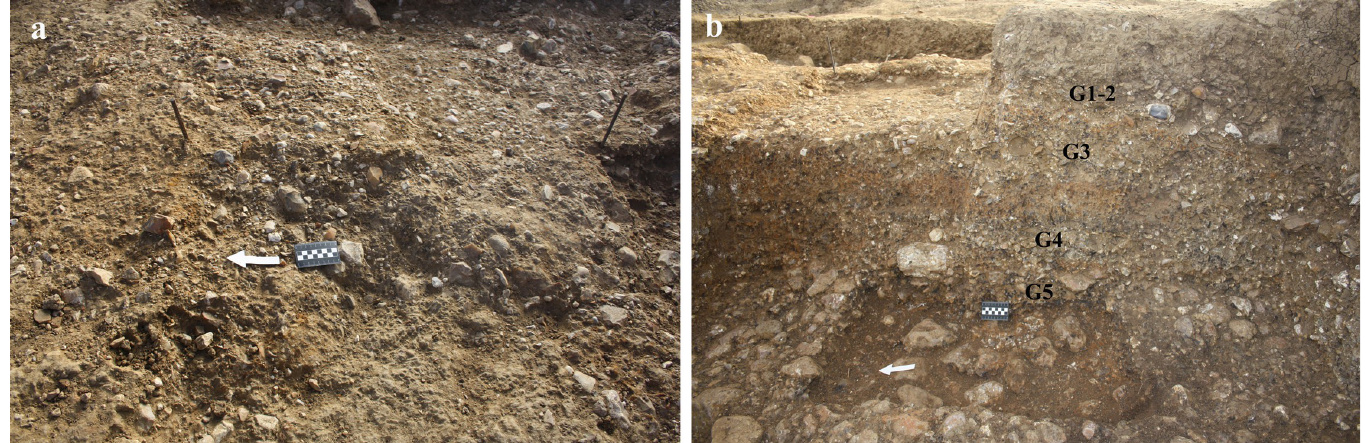
Fig 5. Area G: Horizon G2 (a) and the inner stratigraphy of Unit 4 exposed in that locality